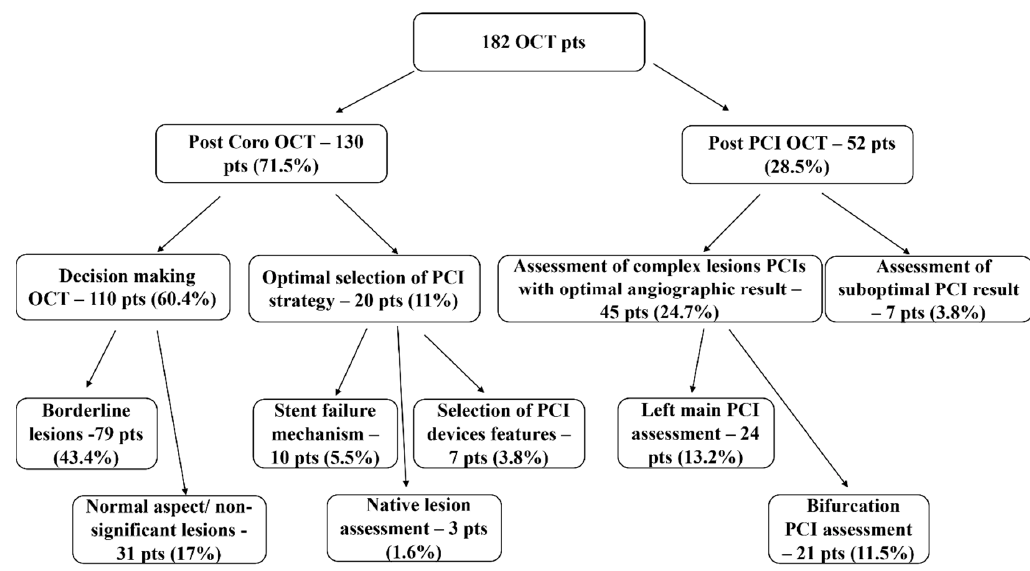
Figure 1. OCT indications. Pts: patients.